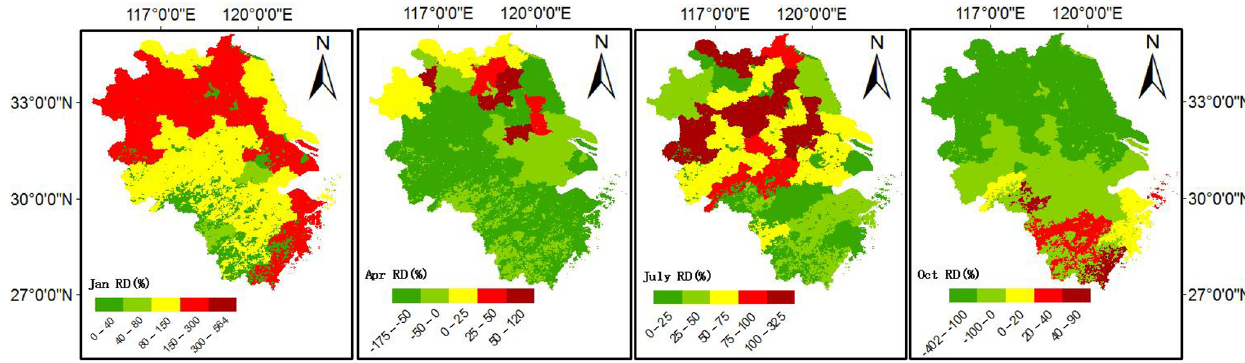
Figure 2. Differences of fertilizer application between the two inventories in YRD (RD = ( E 1 − E 2 )/( E 1 + E 2 )/ 2 )